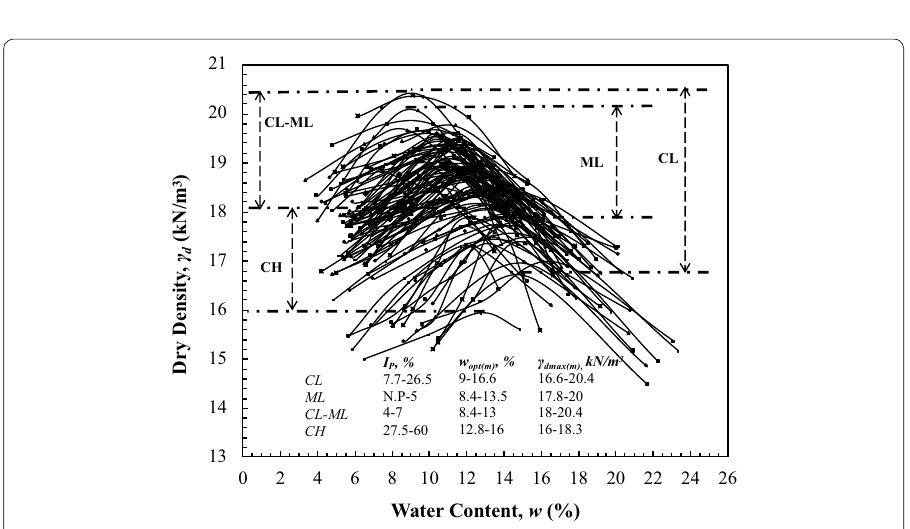
Fig. 3 Modified compaction curves of soil